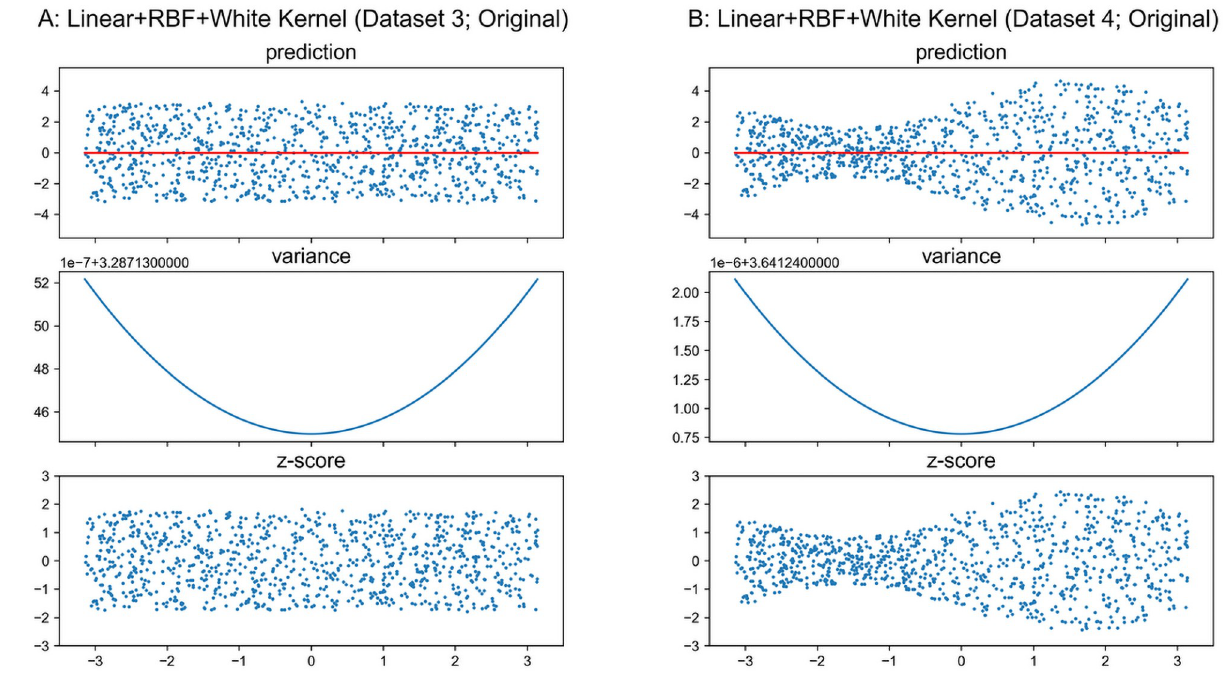
Fig 12. GPR with hybrid kernel on original datasets 3–4. Scales of Y-axis for variance plots are different.